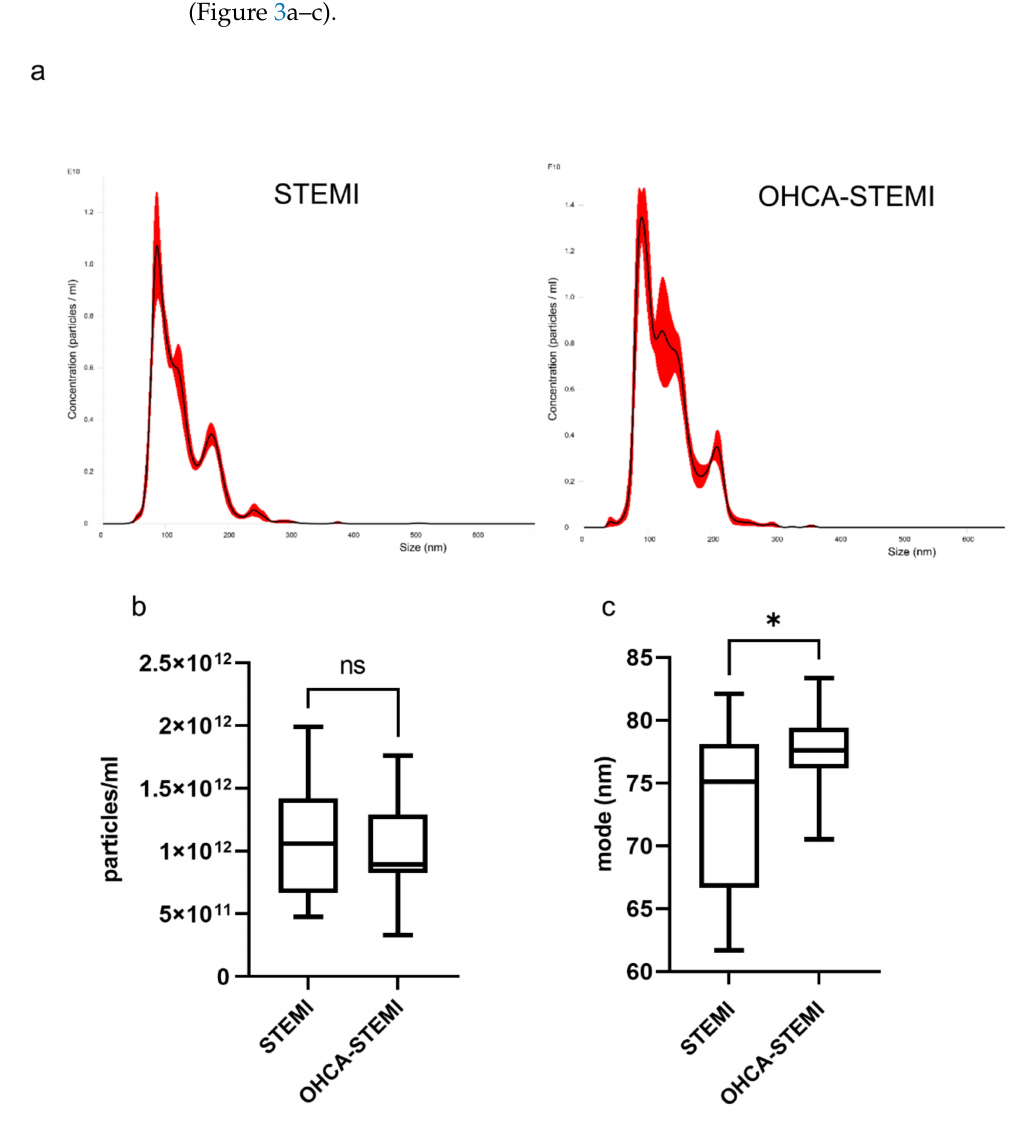
Figure 3. Exosomes isolated from plasma of STEMI with out-of-hospital cardiac arrest (OHCA-STEMI) have a higher dimension compared to uncomplicated STEMI. ( a ) Representative NTA traces of exosomes isolated from plasma of uncomplicated STEMI ( n = 18) and OHCA-STEMI ( n = 17). ( b , c ) Analysis of exosome concentration (number of particles/mL) ( b ) and dimension (mode) ( c ) as assessed by NTA. For each box plot, the center line illustrates the median and box limits indicate the 25th and 75th percentiles. ns: not significant, * p <